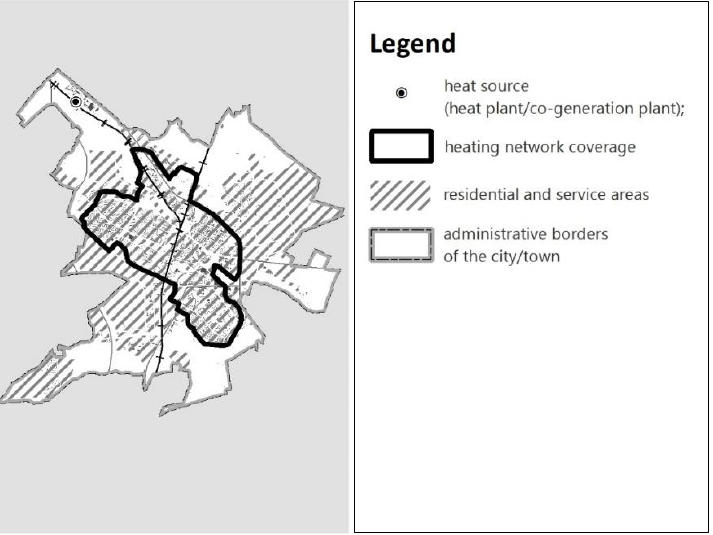
Figure 7. Areas intended for housing and service development, and the range of the district heating network in Lubin. * HSAs—housing and service areas.